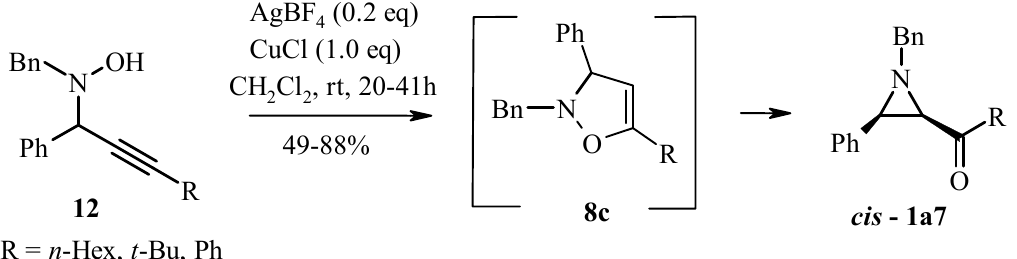
Scheme 18. Cascade cyclization-Baldwin rearrangement reaction of hydroxylamines 12 .